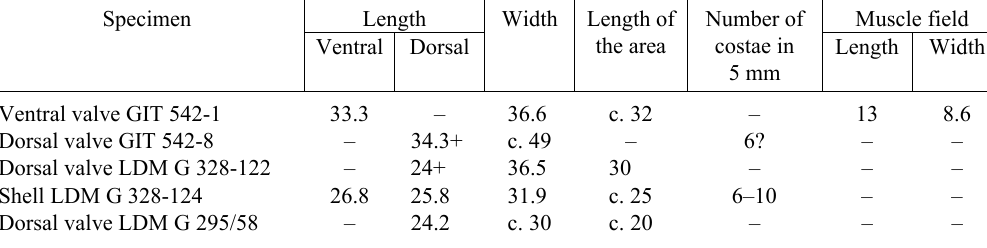
Table 1. Measurements (in mm) of Hirnantia sagittifera (+ the real size is somewhat large; c., approximate size)